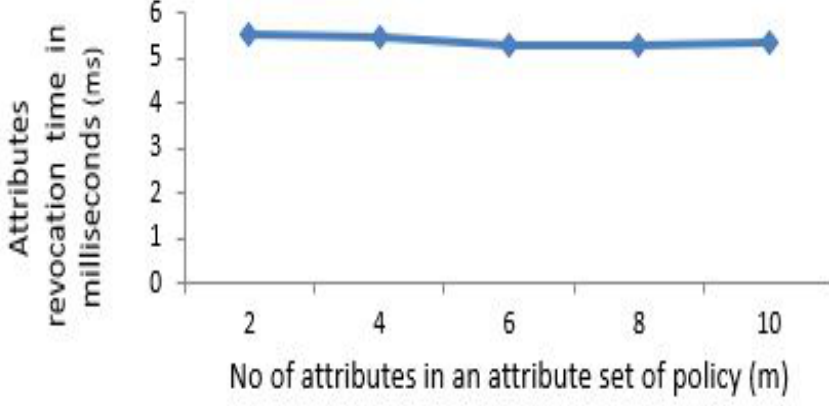
Figure 6. Attributes revocation by patient for policy